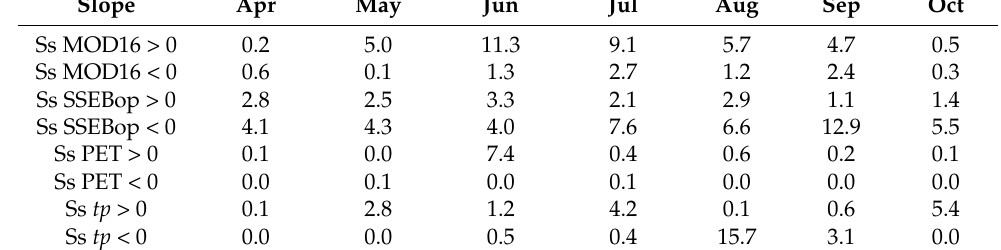
When data were aggregated in elevation ranges (<1000 m, 1000–2000 m, >2000 m), MOD16 trends were mainly positive from May to September, at any elevation, while for SSEBop they showed a high variability, being mostly negative in summer below 1000 m, positive in August above 1000 m, and negative in April and September between 1000 and 2000 m (Figure 5).